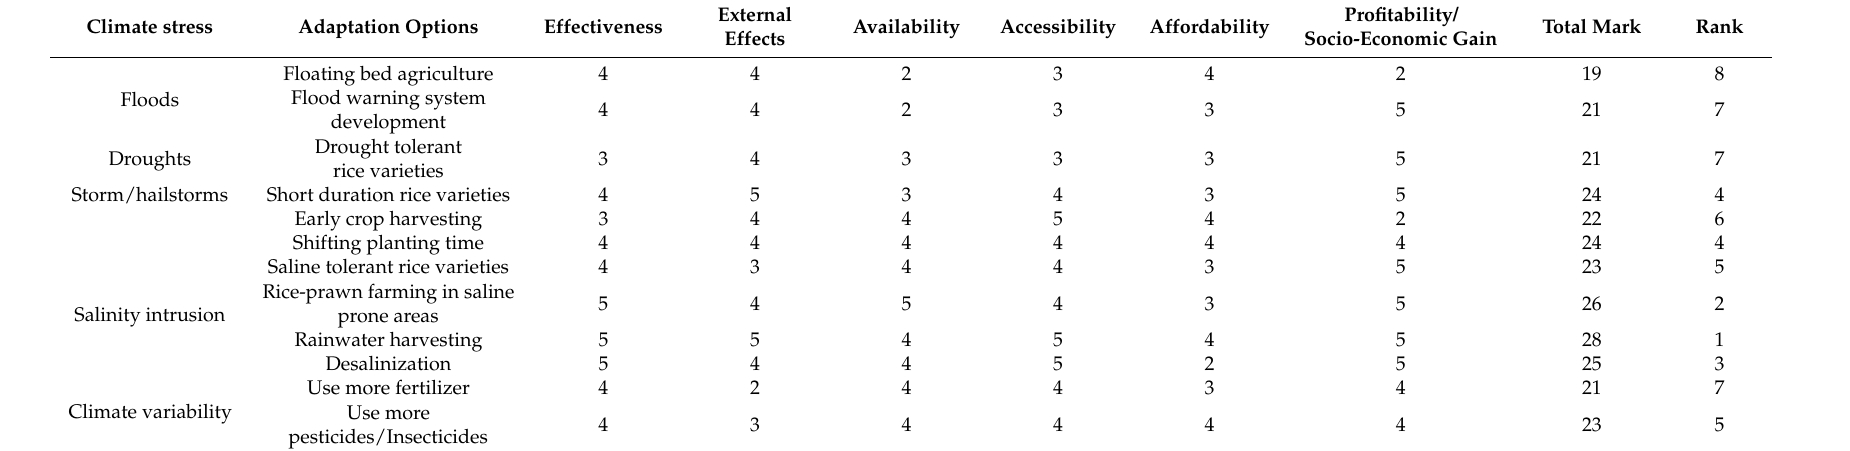
Table 3. Prioritization of adaptation options.